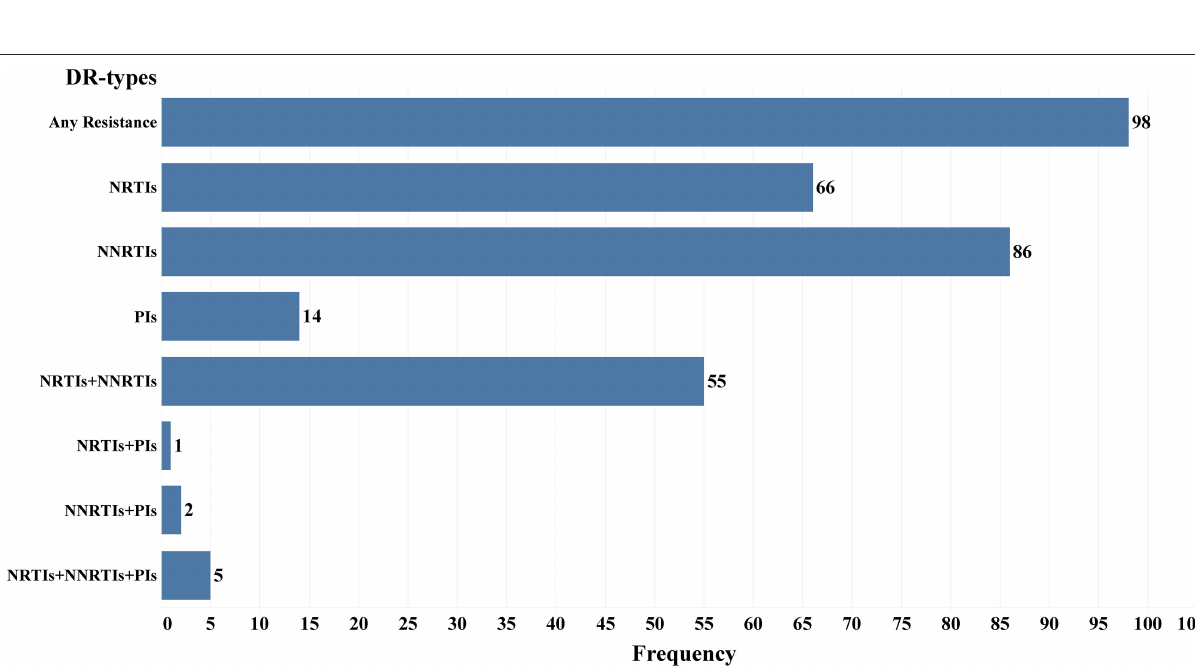
Frontiers in Public Health |